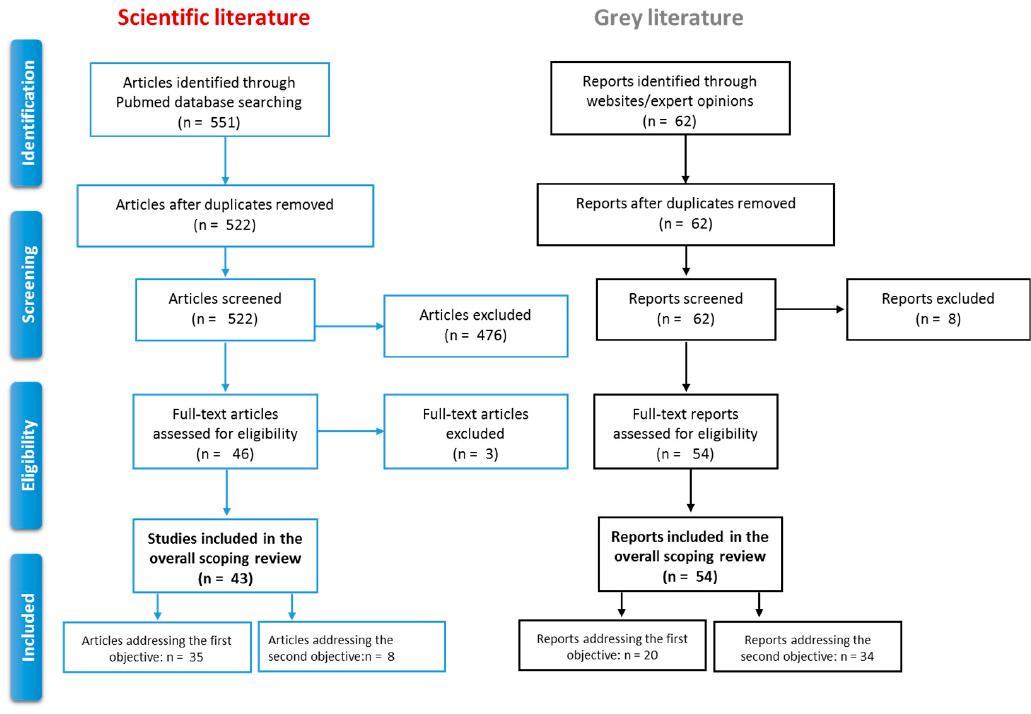
Figure 2. Results of the scientific and grey literature scoping review.